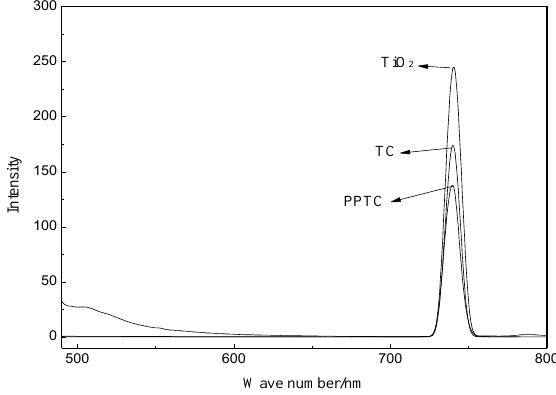
Figure 7. Fluorescence spectra of TiO 2 , TC, and PPTC.